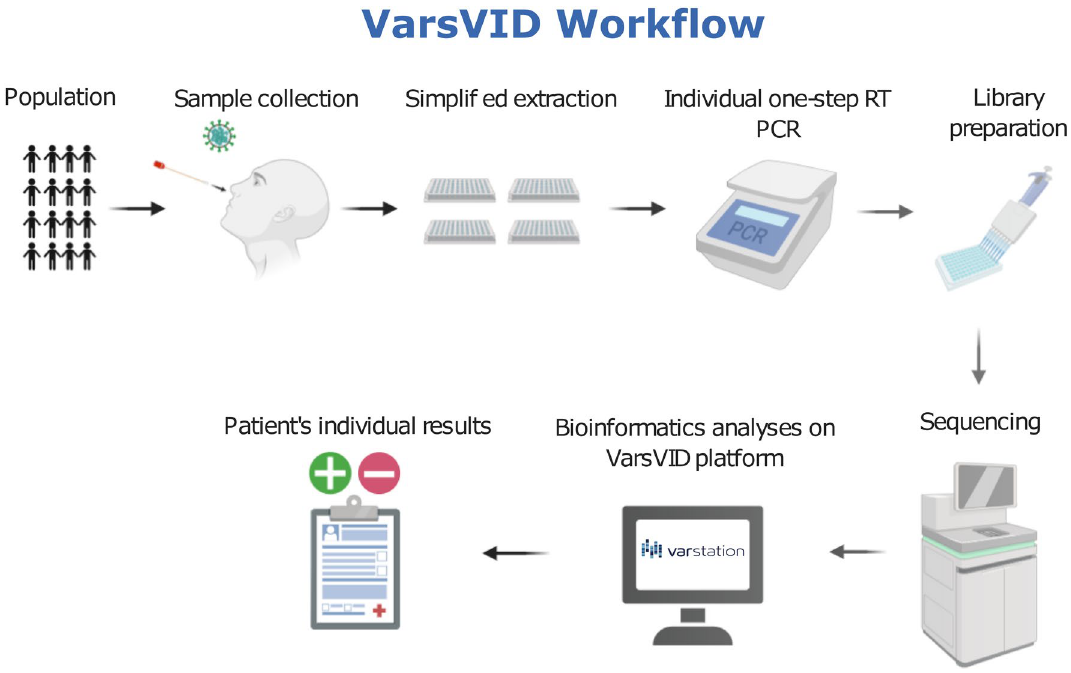
Figure 1. Panoramic view of the COVID19 NGS-based test reported in this work. Created with BioRender.